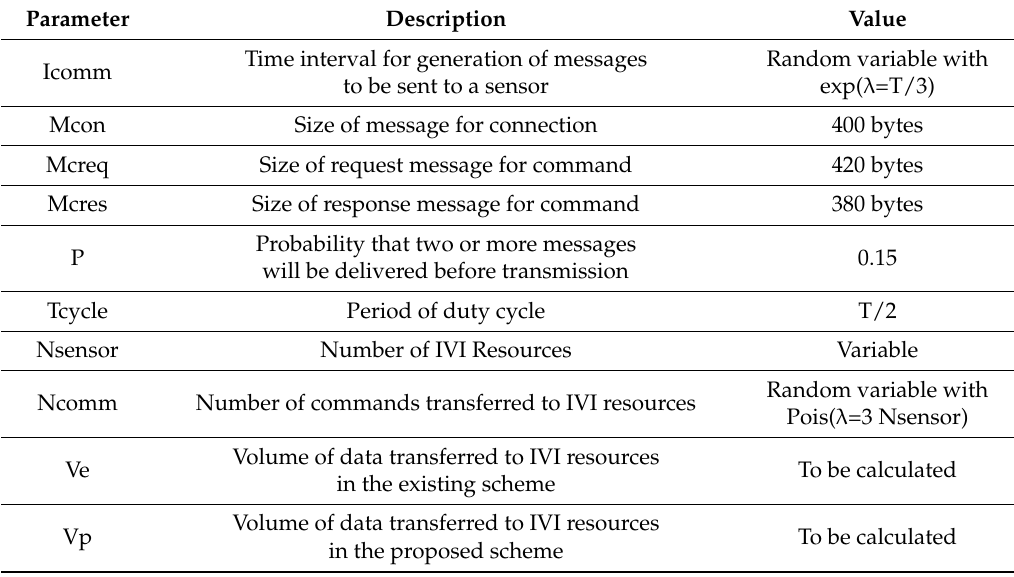
Table 2. Parameter values used for